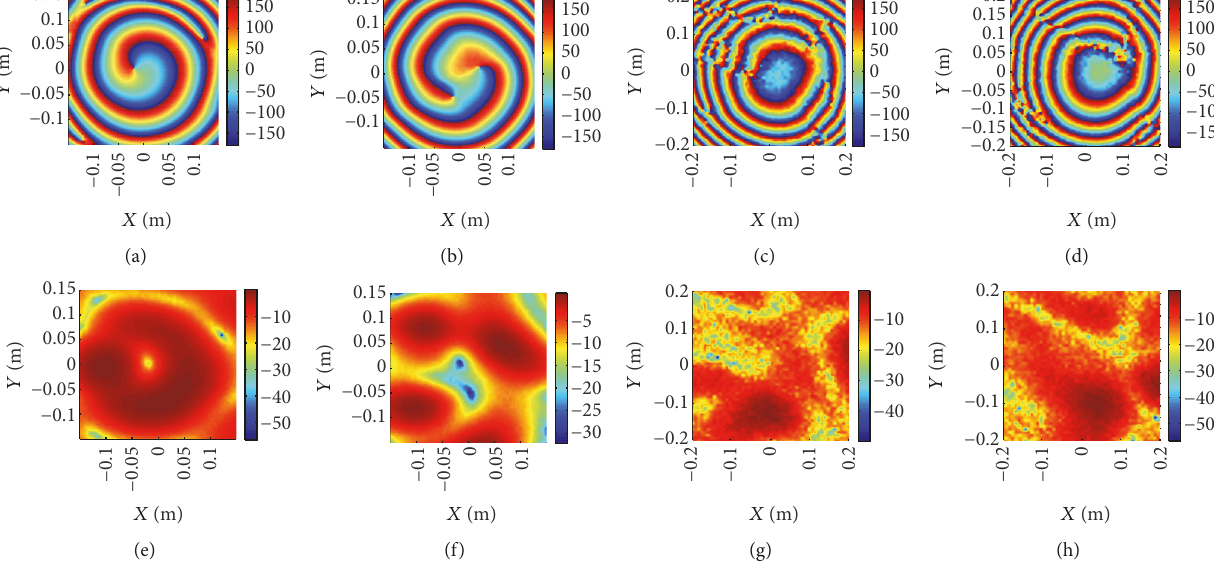
Figure 14: Field characteristics of two OAM modes under the first and second setup. (a, e) and (b, f) refer to the field characteristics when producing OAM modes 1 and 2 in the aligned system, while (c, g) and (d, h) are the field characteristics when producing OAM modes 1 and 2 in the misaligned system. (a, b, c, d) refer to the phase profiles and (e, f, g, h) correspond to the intensity